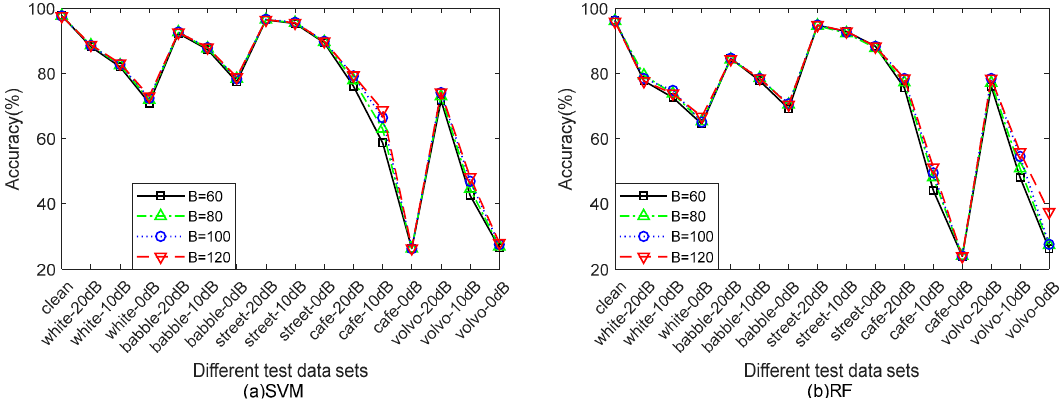
Figure 7. Comparison of different B values.